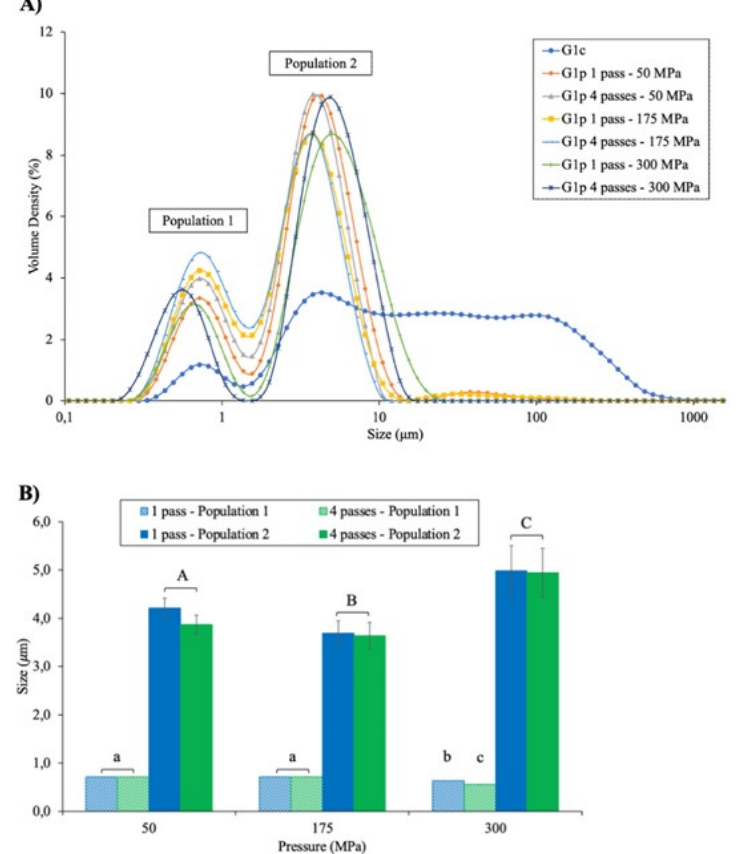
Figure 2. Particle size distribution of initial (G1c) and pressure-treated granule (G1p) at 50, 175 and 300 MPa with 1 and 4 passes ( A ), and factorial effect of pressure level (50, 175 and 300 MPa) and number of passes (1—blue and 4—green) on the two populations (1—hatched and 2—filled) ( B ). Different letters, a–c for population 1 and A–C for population 2, indicate significant differences ( p < 0.05) due to interaction between pressure and passes and solely due to the pressure level (Tukey test, α = 0.05, n = 3).